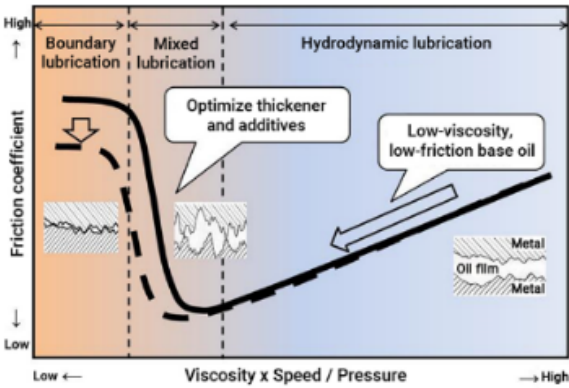
Figure 4: Stribeck curve (Source: www.eneos.co.jp/english/company/rd/intro/lubricants/eco.h